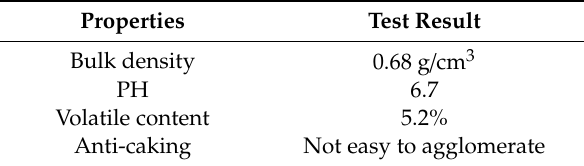
Table 6. Basic properties of the super absorbent polymer (SAP).